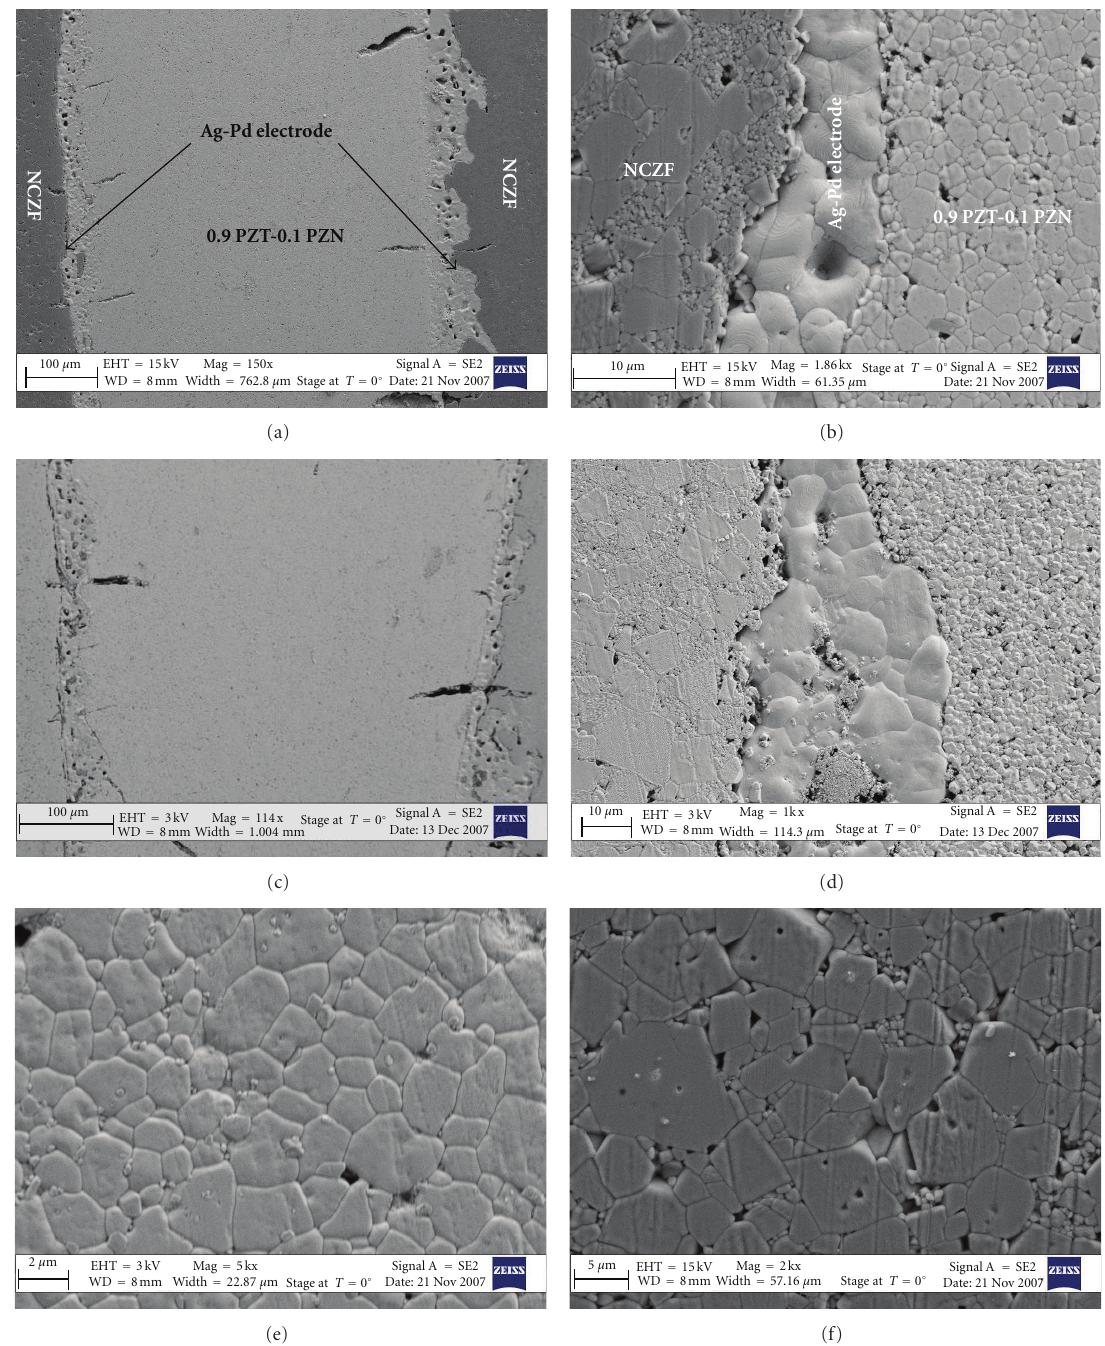
Figure 14: SEM micrographs. (a) low magnification image of sintered trilayer sample, (b) interface microstructure, (c) low magnification image of sintered and annealed sample, (d) interface microstructure of sintered and annealed trilayer sample, (e) grain structure of PZT side and (f) grain structure of NZF